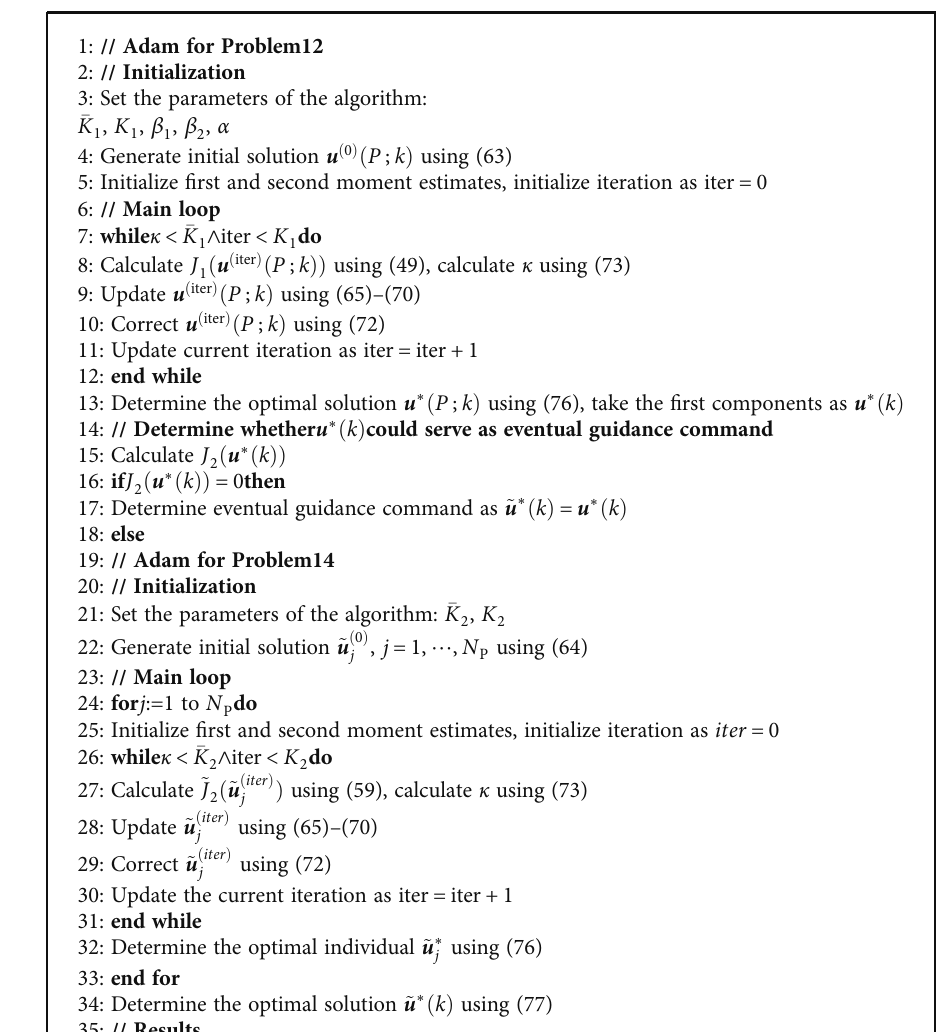
in several situations. 2